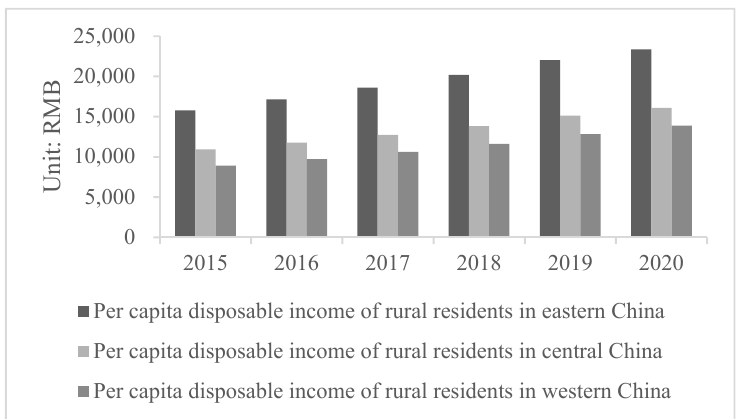
Figure 2. Rural resident per capita disposable income in different Chinese regions from 2015 to 2020 (Data source: National Bureau of Statistics of China).